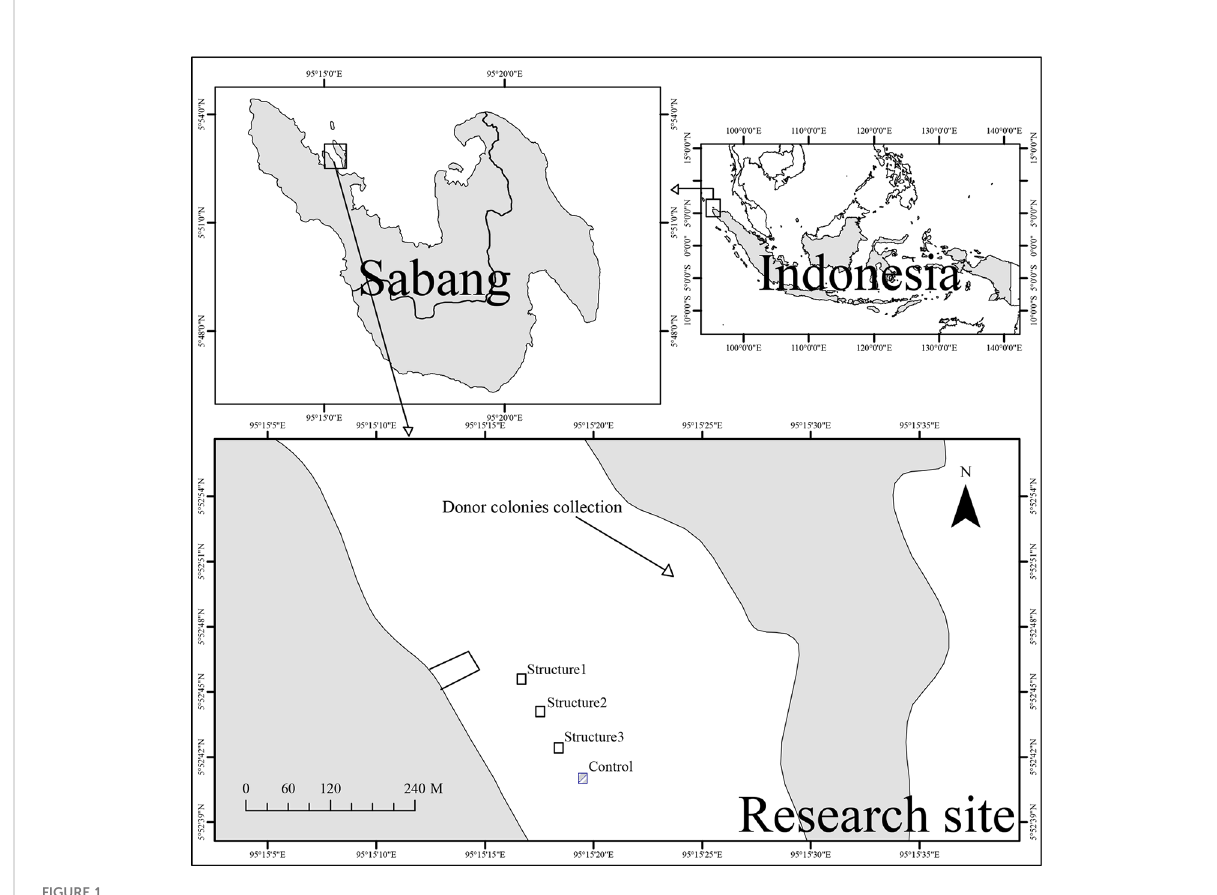
FIGURE 1 Map of experimental